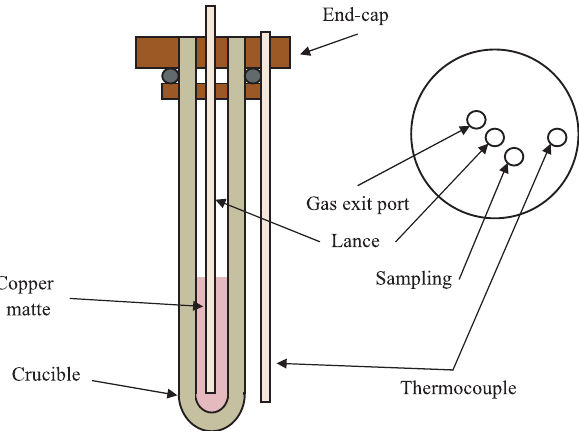
Fig. 1: Schematic of the crucible